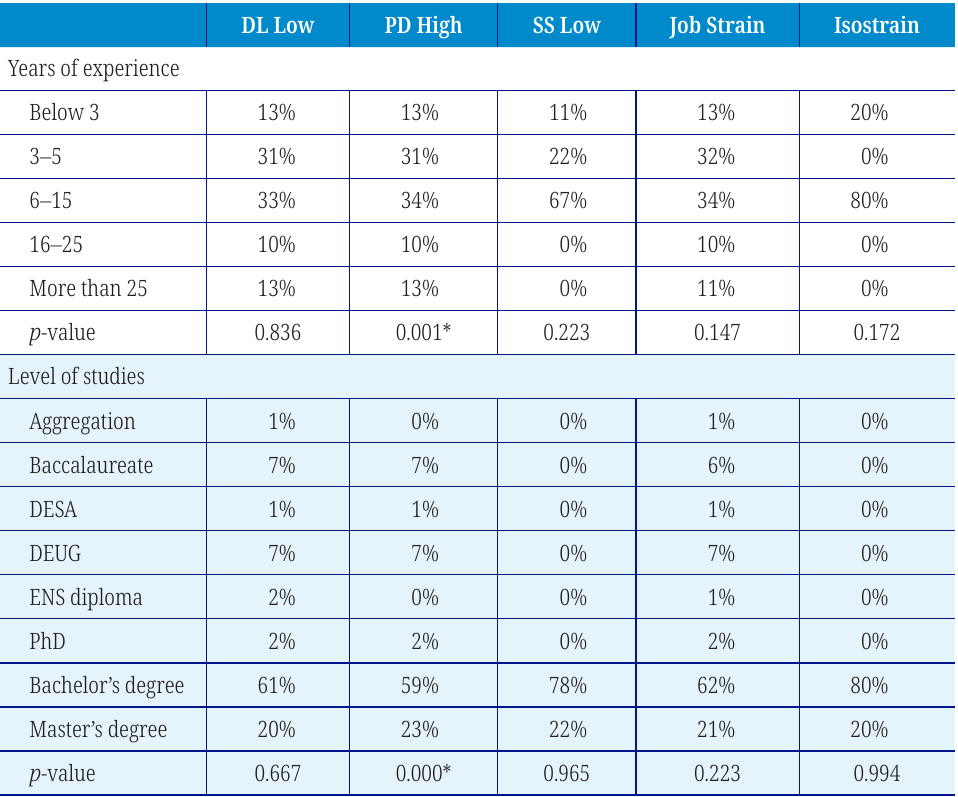
Table 7. Distribution of studied population according to years of experience, level of studies, and psycho-organizational dimensions (N = 218)